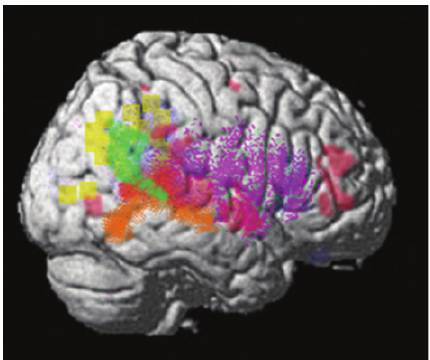
Figure 1: Summary figure of the overlap of functional regions in the TPJ (inferior parietal and PSTS); this region is involved in eye gaze (red); audiovisual speech (orange); self-representation (yellow); theory of mind (green); emotional perception of faces and prosody (dark blue and purple). Rerepresentation of data is, respectively, from [37–40, 47].